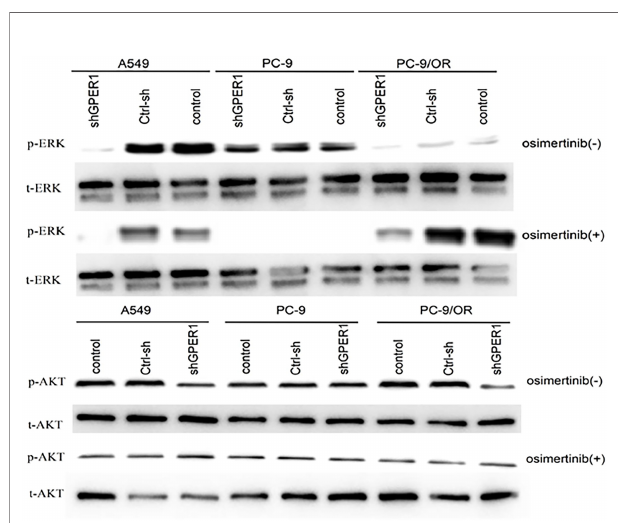
FIGURE 6 | Knockdown of GPER1 signi fi cantly decreased the expression levels of p-ERK1 and P-AKT in EGFR-TKIs resistant cells, but did not in EGFR-TKIs sensitive cells.